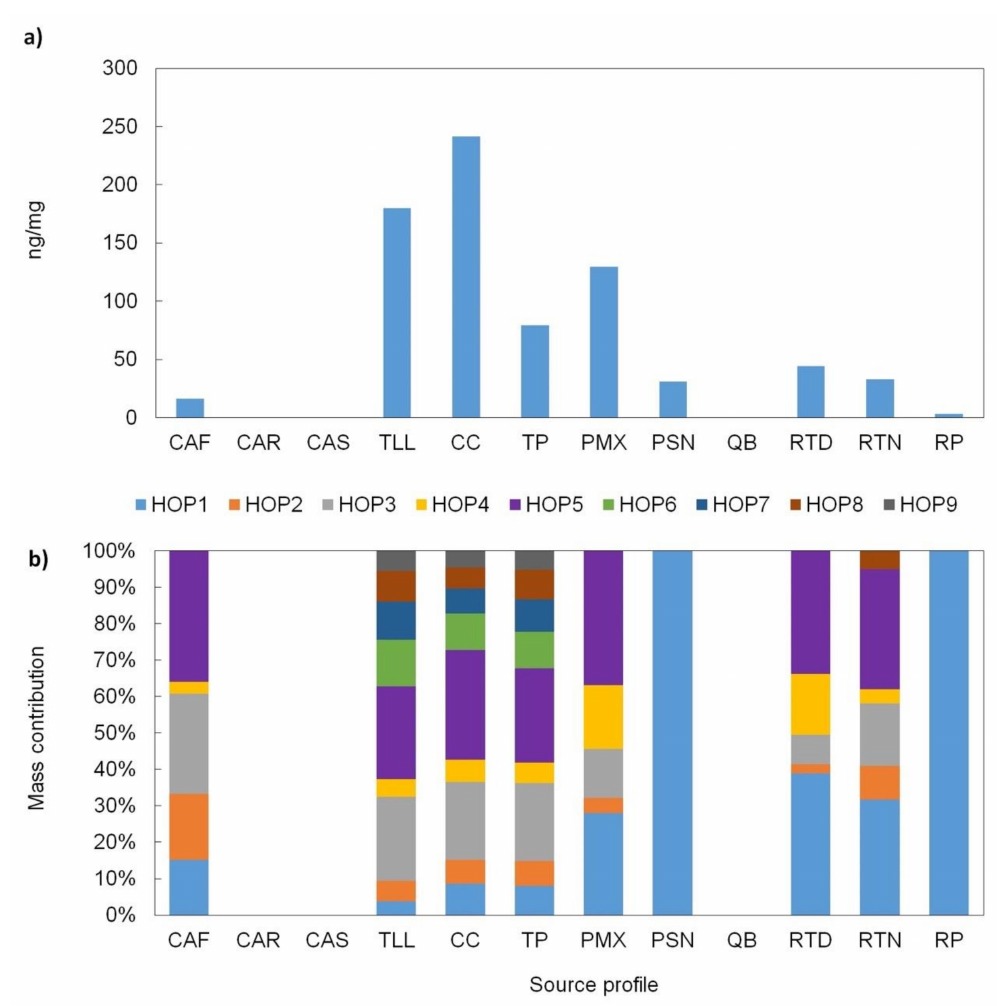
Figure 6. ( a ) Hopanes total concentration and ( b ) mass contribution of individual hopanes to the total hopanes EOM for each source profile. Definition of source profile codes are presented in Table